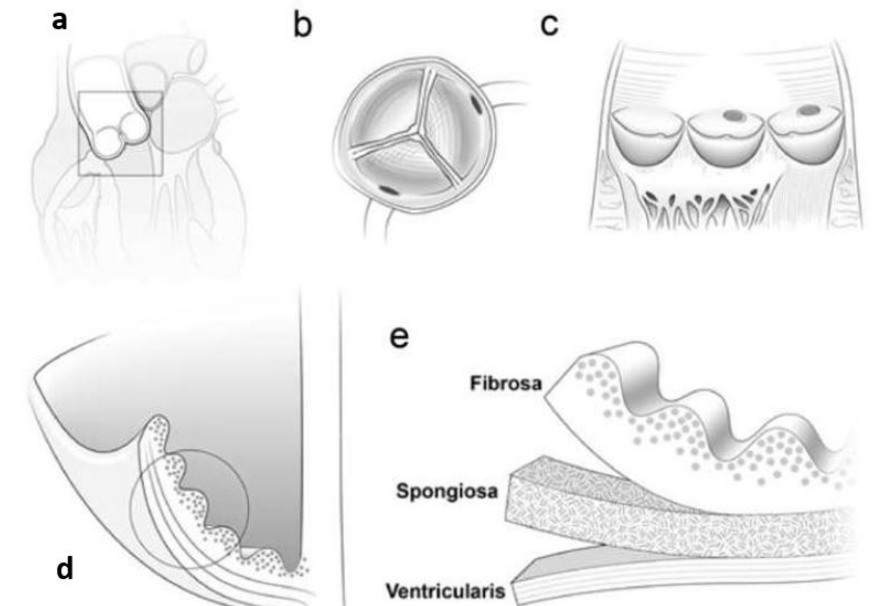
Figure 5. Aortic heart valve anatomy in schematic form. An aortic valve is shown in ( a ) a cross- sectional image of the heart. Illustration: ( b ) Aortic valve looking from above (seen from the aortic side). ( c ) View of the splayed-open valve from the side, revealing the semilunar shape of the cusps. ( d ) A sectional view through the cusp and aortic wall, revealing the cusp’s three-layer structure. ( e ) The collagen fibril orientations of the three cusp layers (fibrosa, spongiosa, and